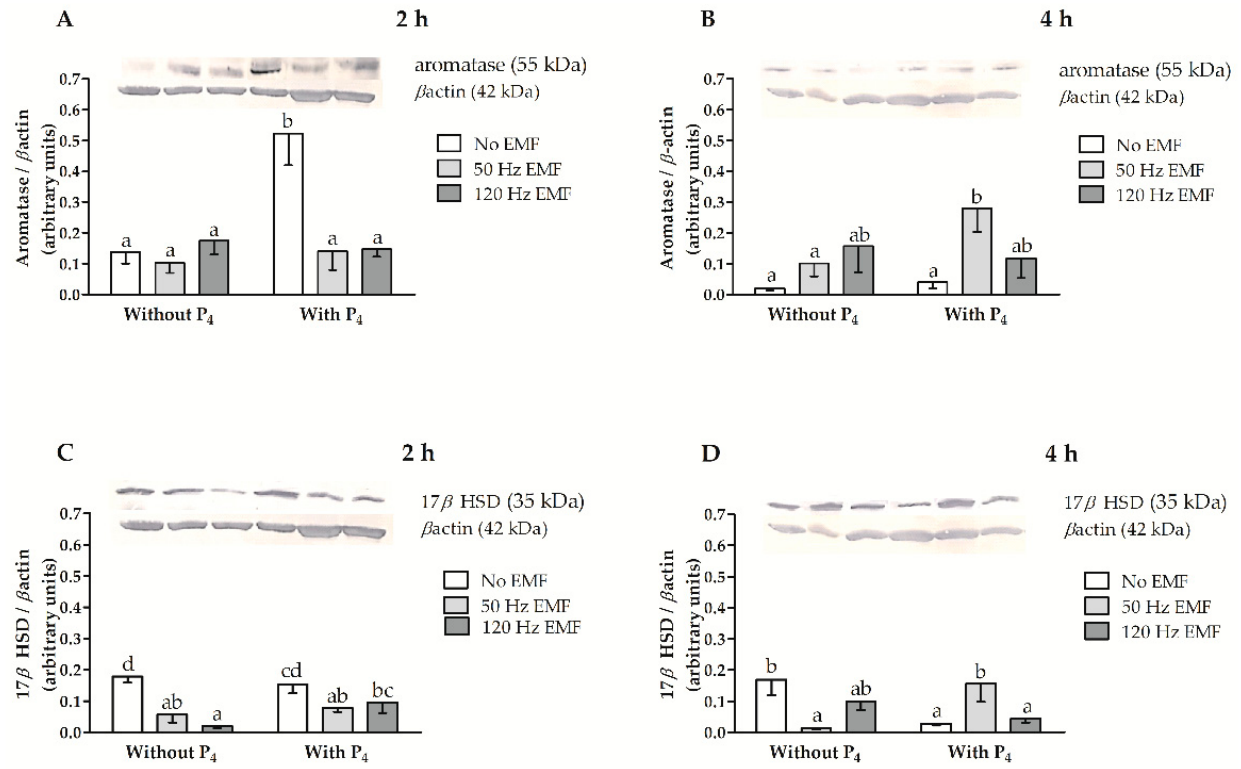
Figure 4. The relative abundance of cytochrome P450arom (aromatase) ( A , B ) and 17 β hydroxysteroid dehydrogenase (17 β HSD) ( C , D ) protein abundances in myometrial slices collected from pigs during days 15–16 of early pregnancy and treated in vitro with an EMF at 50 and 120 Hz for 2 h ( A , C ) and 4 h ( B , D ) of incubation with or without the inclusion of P 4 in the culture medium. Data are presented as mean ± SEM. Lower-case letters (a–d) above bars indicate statistically significant differences at p ≤ 0.05 (multi-way ANOVA).